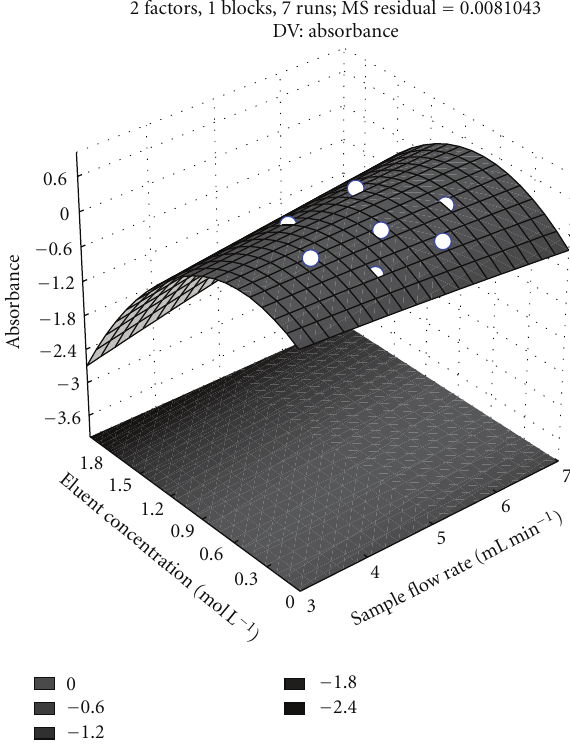
Figure 4: Response surface for optimization of eluent concen- tration and sample flow rate: sample volume, 10.0 mL; sample concentration, 10 μ gL − 1 ; sorbent mass, 30 mg; pH,